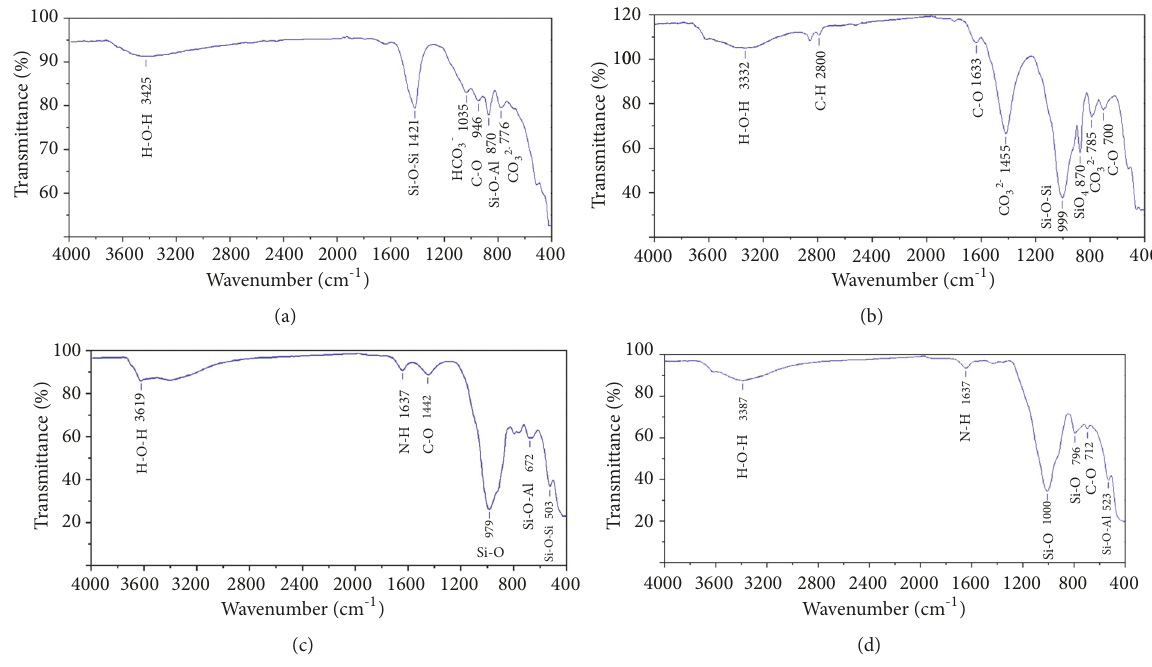
Figure 3: Sediments FTIR spectra of station N ∘ 1 (a); station N ∘ 2 (b); station N ∘ 3 (c); station N ∘ 4(d).